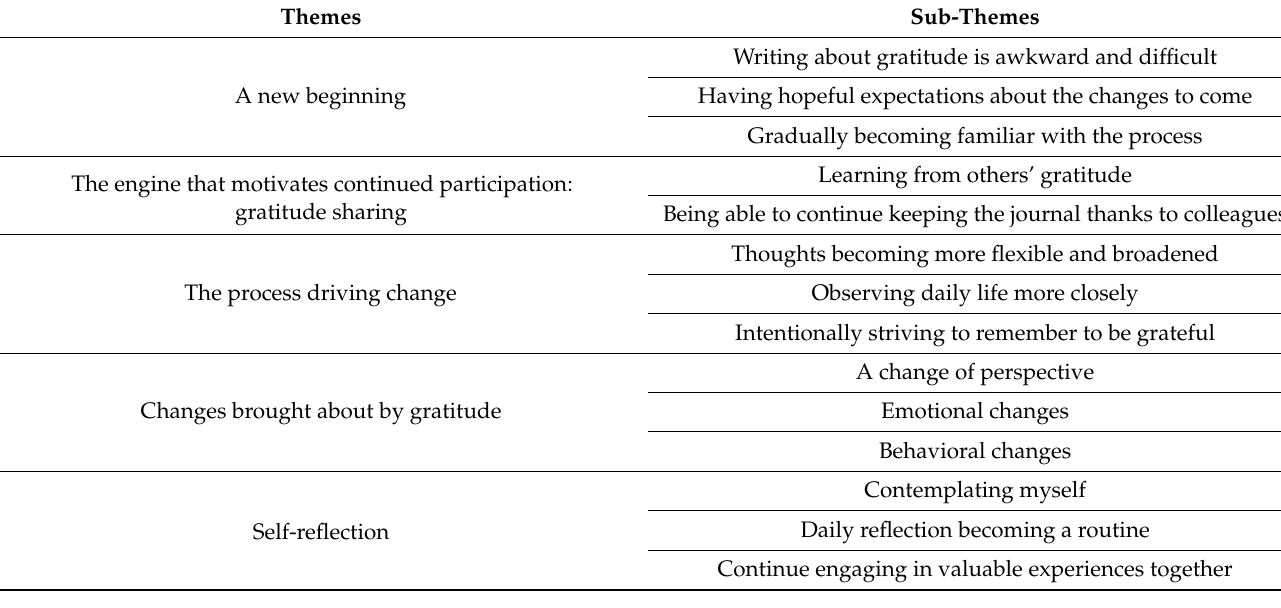
Table 2. Themes that emerged from the gratitude journaling